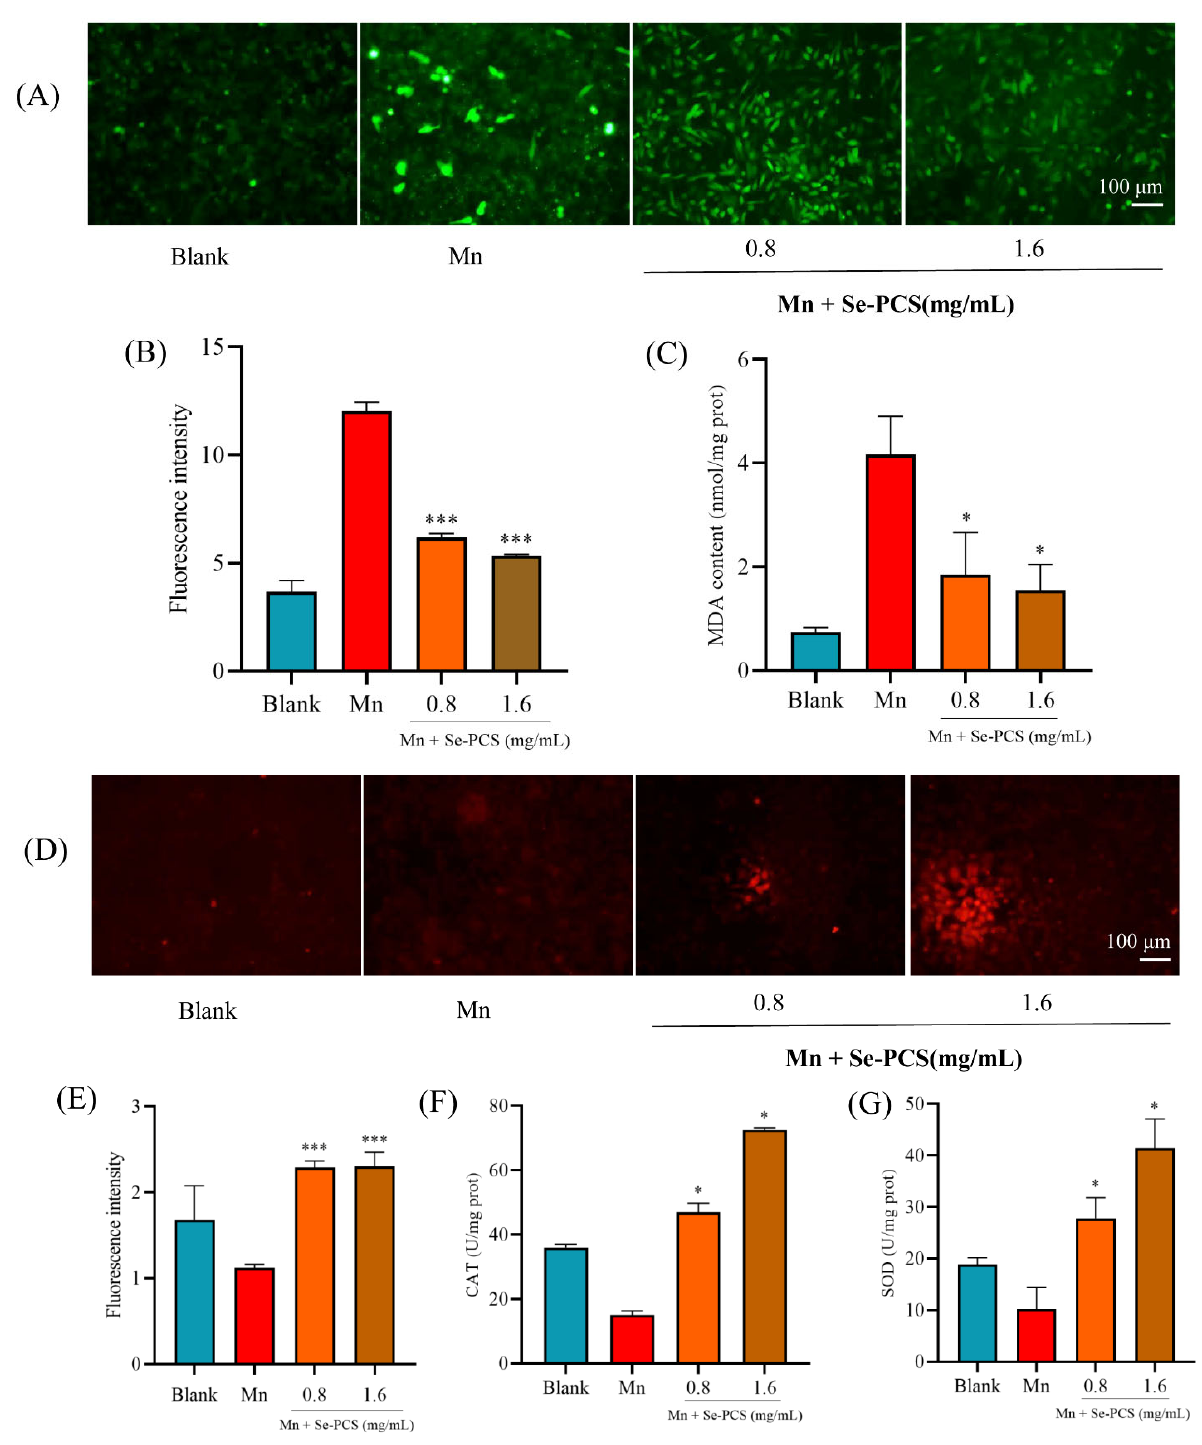
Figure 5. On the condition of MnCl 2 (1.6 Mm), the effect of Se-PCS on ( A ) the ROS level in Hep G2 and ( B ) the changes in ROS level; ( C ) the MDA content in Hep G2 cells. The effect of Se-PCS on ( D ) the GSH level in Hep G2 and ( E ) the changes in GSH levels. The activities of antioxidant enzymes in cells include ( F ) CAT and ( G ) SOD; * and *** mean p < 0.05 and p < 0.001, respectively, compared with the Mn